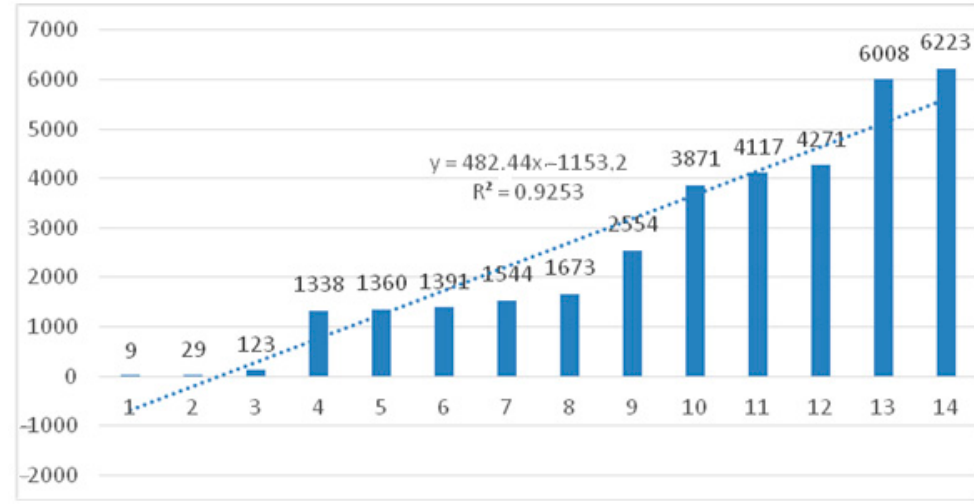
Figure 6. Trend equation of energy recovery from biodegradable municipal waste consumption (in TJ) in 2008–21. Table 3. Forecasts and forecast errors of energy recovery from municipal waste until 2030.